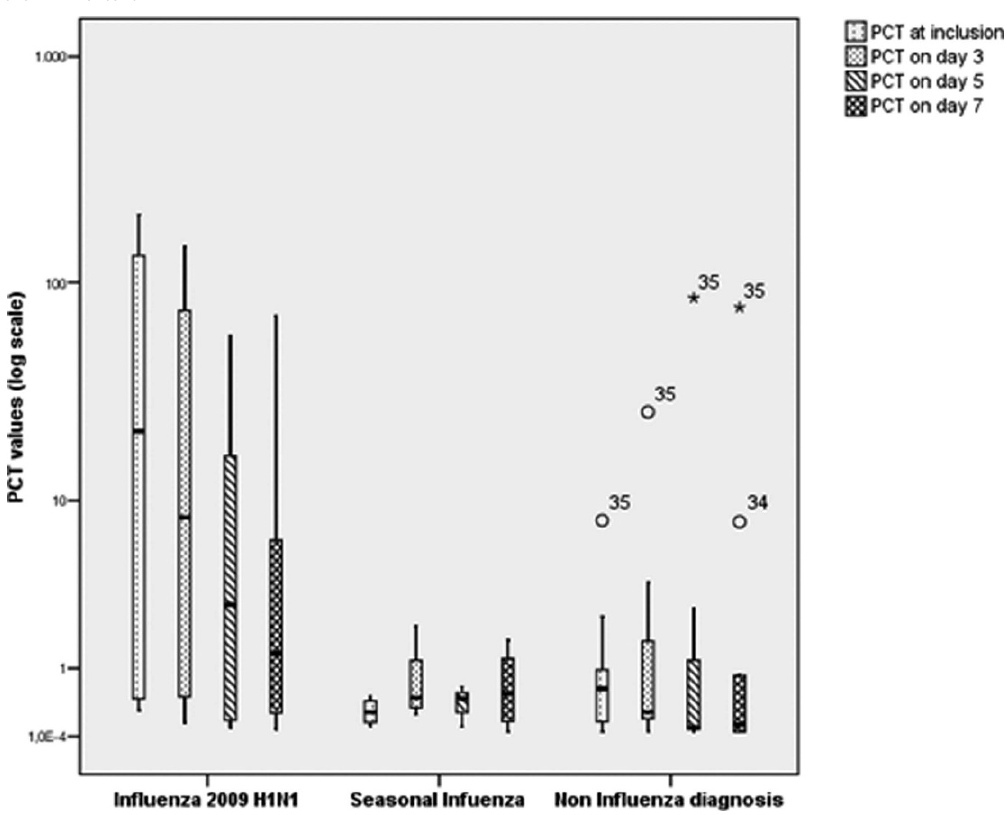
Figure 1 - The circulating levels of procalcitonin observed in the studied patients at the four points of measurement, according to the respective